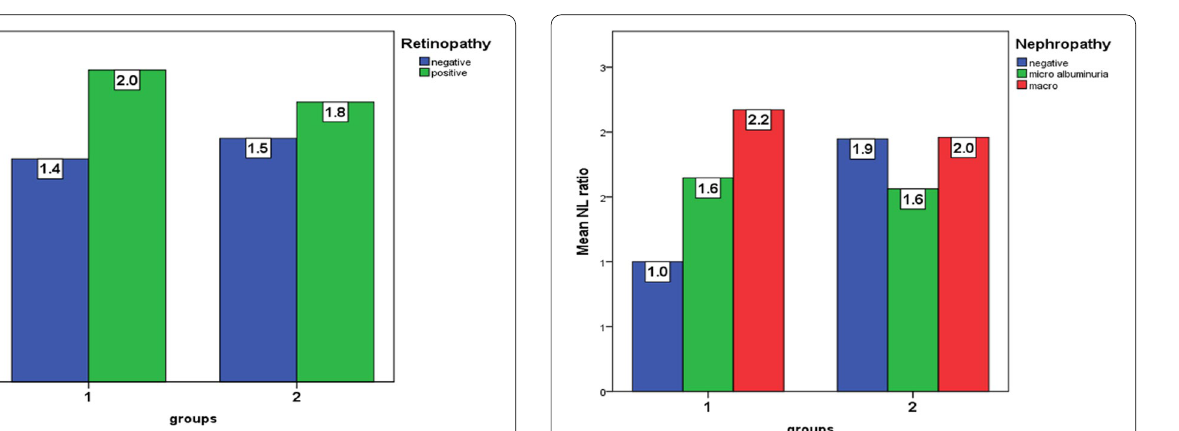
Fig. 3 The difference in the mean value of NLR in geriatric patients who screened for nephropathy with A/C ratio in both Group 1 (DM HTN) and Group 2 (only DM) individually